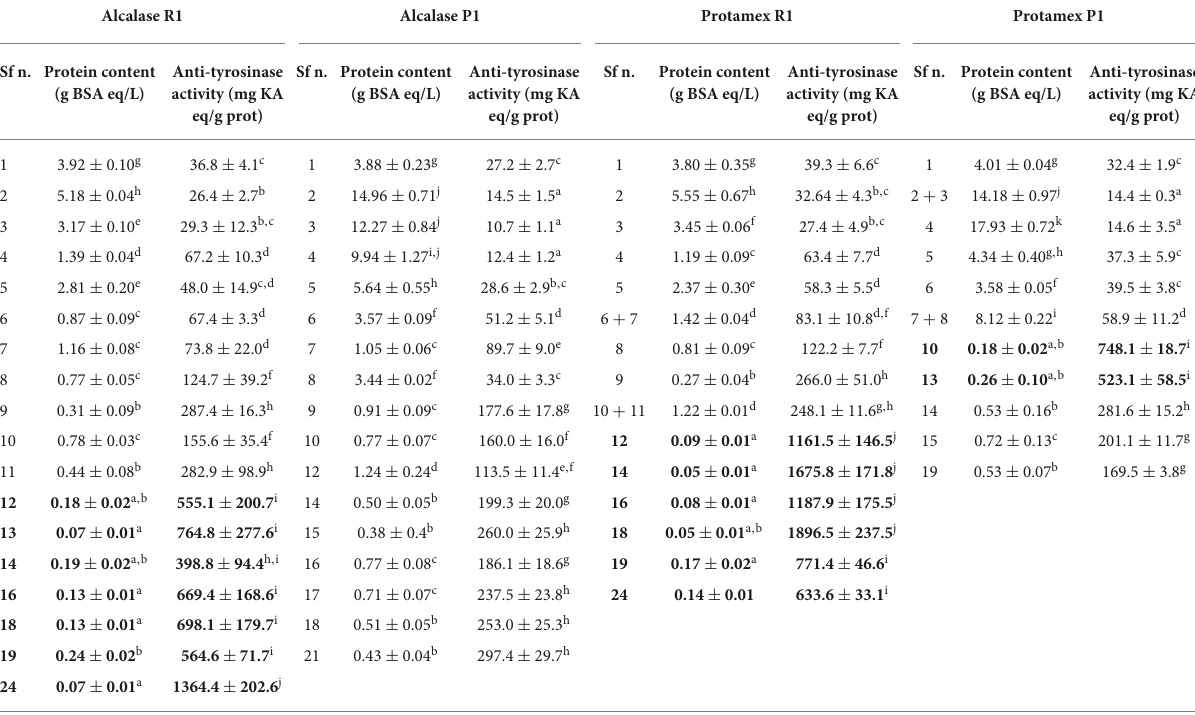
TABLE 2 Protein content (g BSA eq/L) and anti-tyrosinase activity (mg KA eq/g prot) in peptide